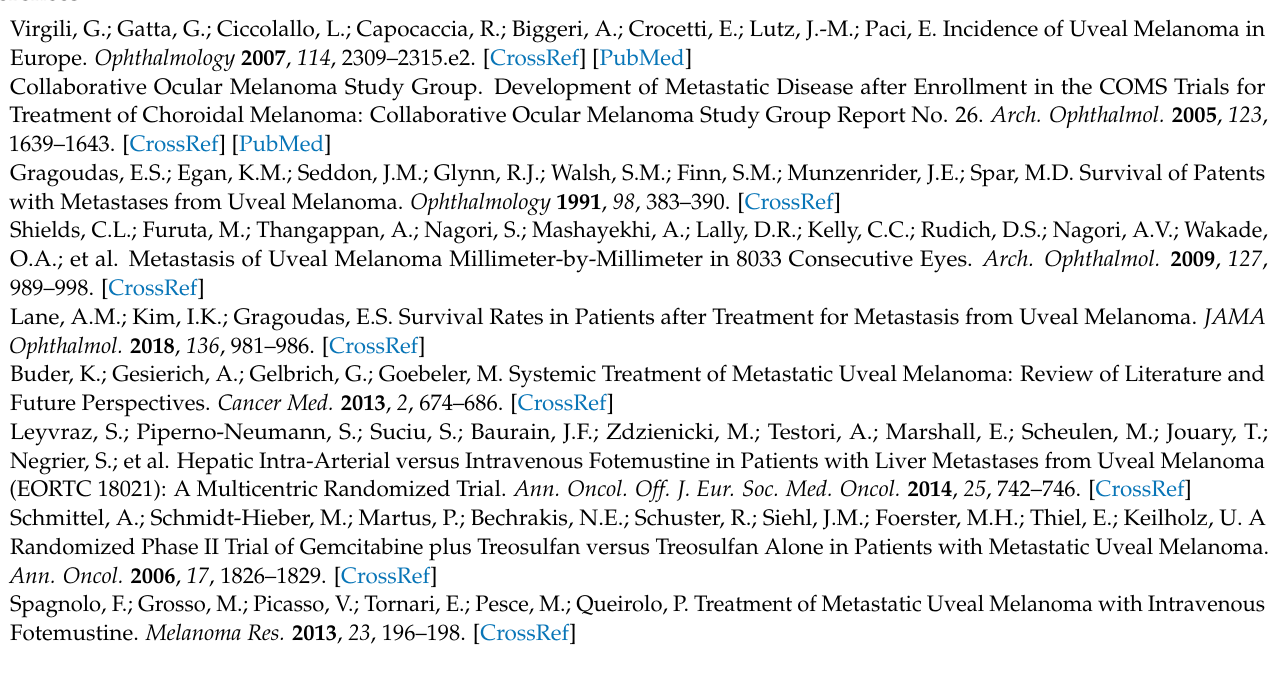
Univariate analysis of overall survival and hepatic progression-free survival. Table S3: Comparative table of outcomes of different studies using ipilimumab and nivolumab and/or SIRT as treatment for metastatic uveal melanoma. Figure S1: Survival curves and hepatic progression-free survival from